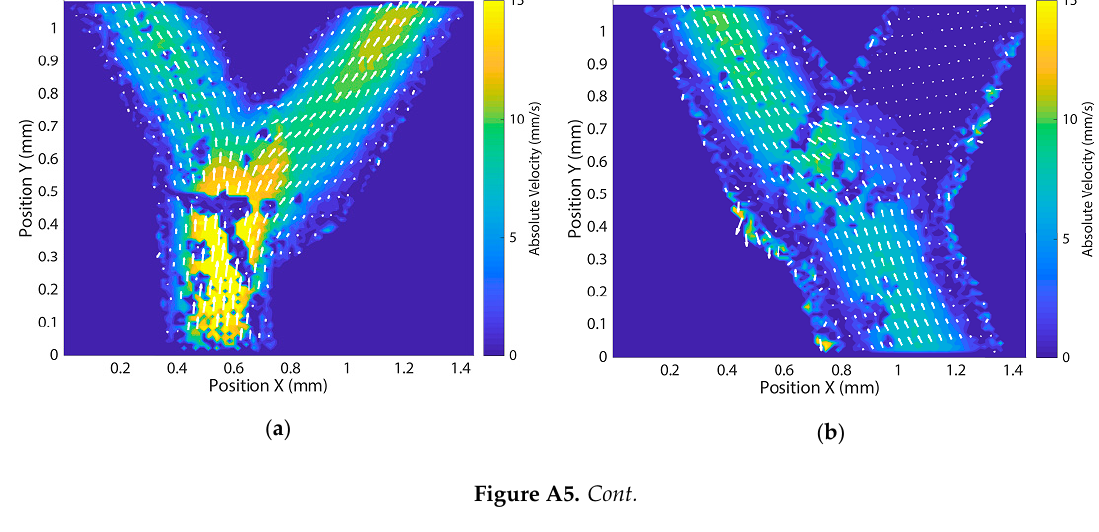
Figure A5. Cont. Figure A5.